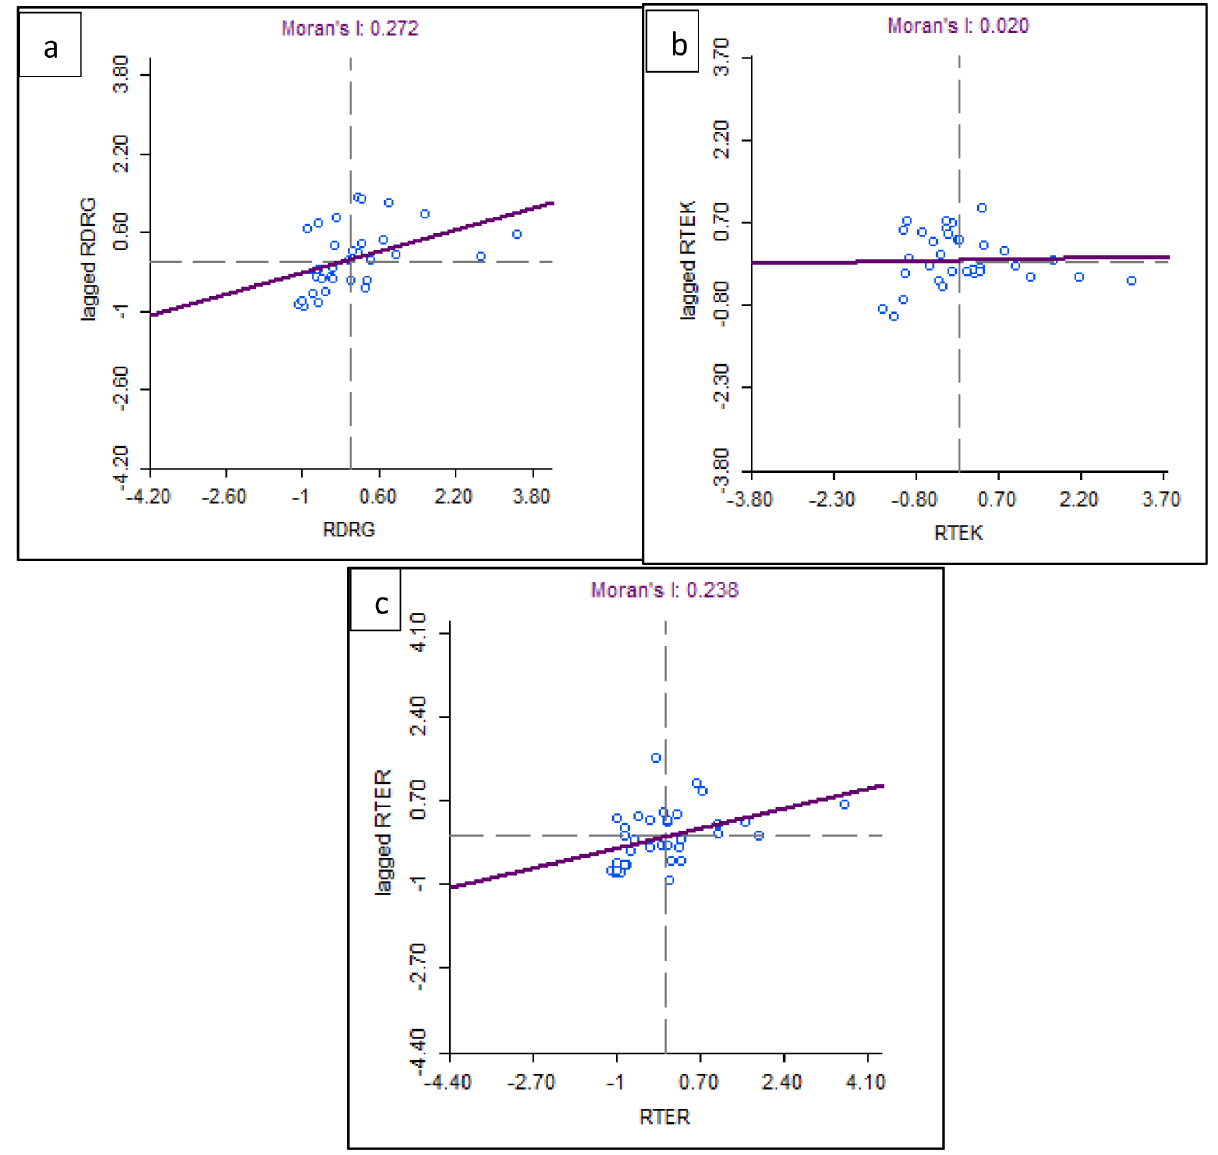
Figure 6. Spatial autocorrelation with Moran’s index of dentists per area ( a ), dental therapists per area ( b ), and dental technicians per area was developed ( c ). The X axis is referring to the number of observations and is also known as the response axis. The Y axis is referring to the average or spatial lag of the corresponding observation of dental health personnel per area of the X